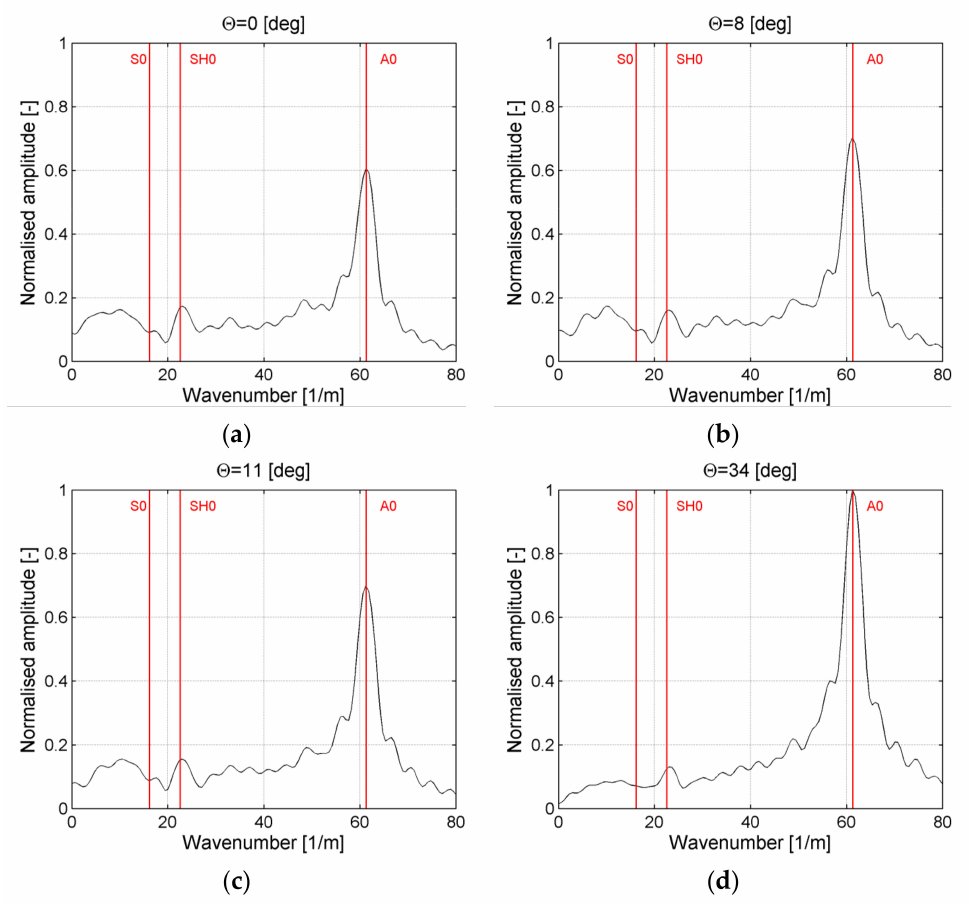
Figure 12. Amplitude–wavenumber plots for ACT slope angle θ equal: ( a ) 0 ◦ , ( b ) 8 ◦ , ( c ) 11 ◦ , ( d ) 34 ◦ ; waves generation across reinforcing fibers.